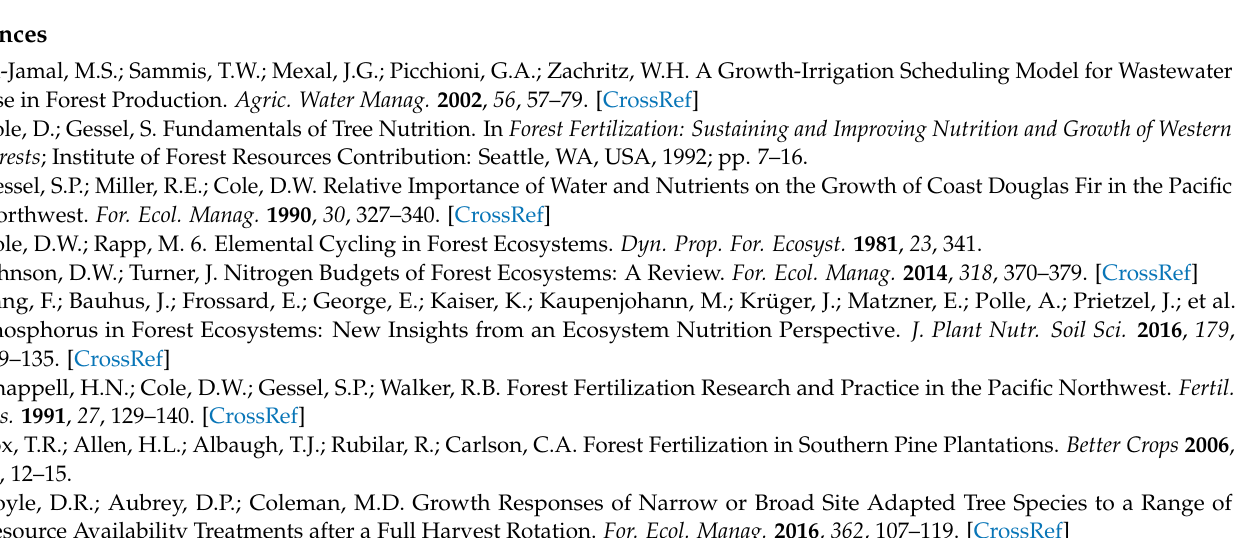
Figure A2. Location of five control plots (201HC1, 202HC2, 203HC3, 204HC4 and 205HC5) and five effluent plots (206HE1, 207HE2, 208HE3, 209HE4 and 210HE5) at Heyburn State Park facility demonstrating the unique spatial distribution of study plots. The land application site is the area enclosed by the yellow